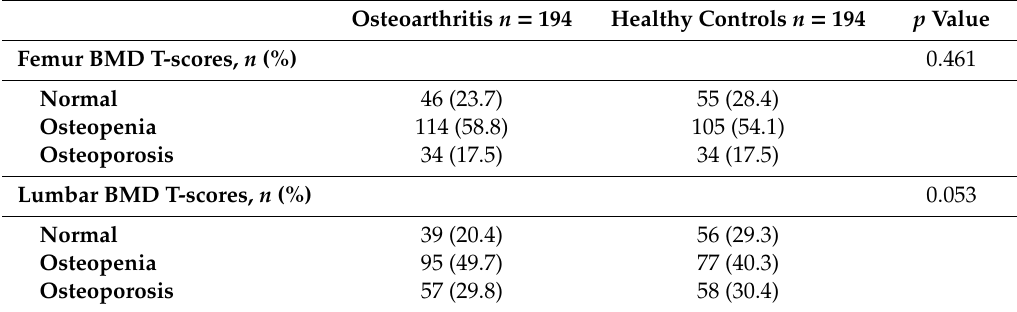
Table 5. Comparison of the distributions of the BMD categories between the patients with knee osteoarthritis and the healthy controls except for patients with previous fractures and male patients.